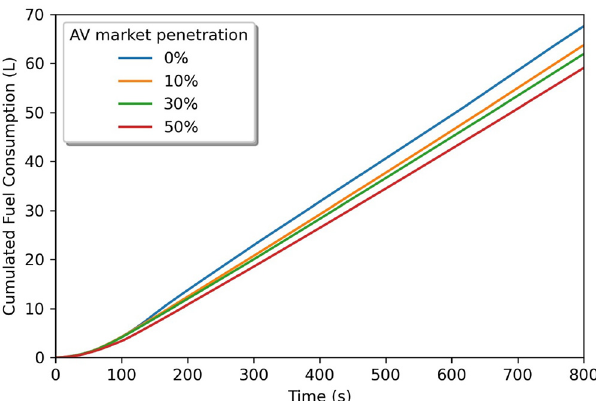
Figure 6 Cumulative fuel consumption on the simulated freeway segment considering different market penetration of SSDM-equipped